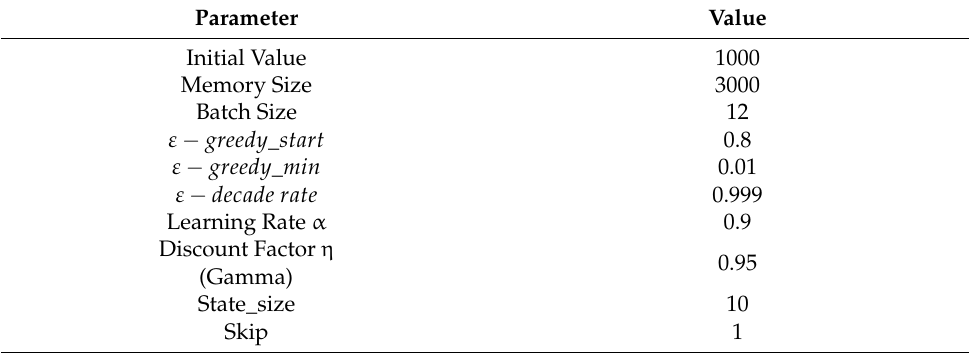
Figure 9. Deep Q ‐ learning network (DQN) architecture for the XXY platform. Figure 9. Deep Q-learning network (DQN) architecture for the XXY platform. Table 3. Parameters of the DQN.